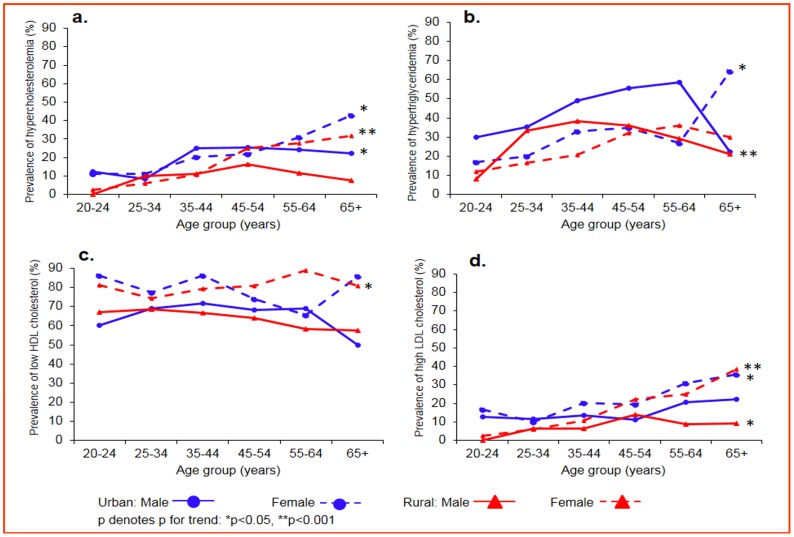
a-d: Age- and sex-specific prevalence of dyslipidemia in the study population.Urban male, blue circles, solid line; urban female, blue circles, dotted line; rural male, red triangles, solid line; rural female, red triangles, dotted line; p denotes p for trend; *p<0.05, **p<0.001.